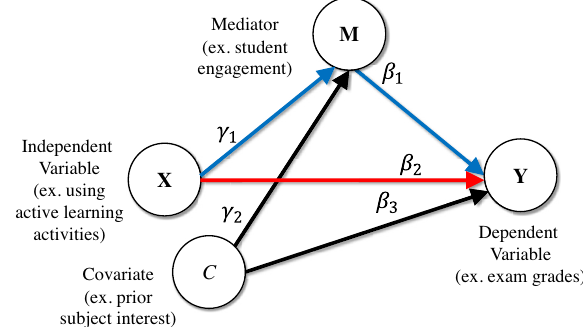
FIG. 2. A qualitative graphical depiction of a mediated relation- ship between two variables. X , Y , and M represent the model ’ s independent, dependent, and mediating variables while C repre- sents a covariate. A researcher who observes a positive relation- ship between using active learning activities in the classroom and the exam grades of students might posit that a third variable, student engagement, is actually responsible for causing the observed